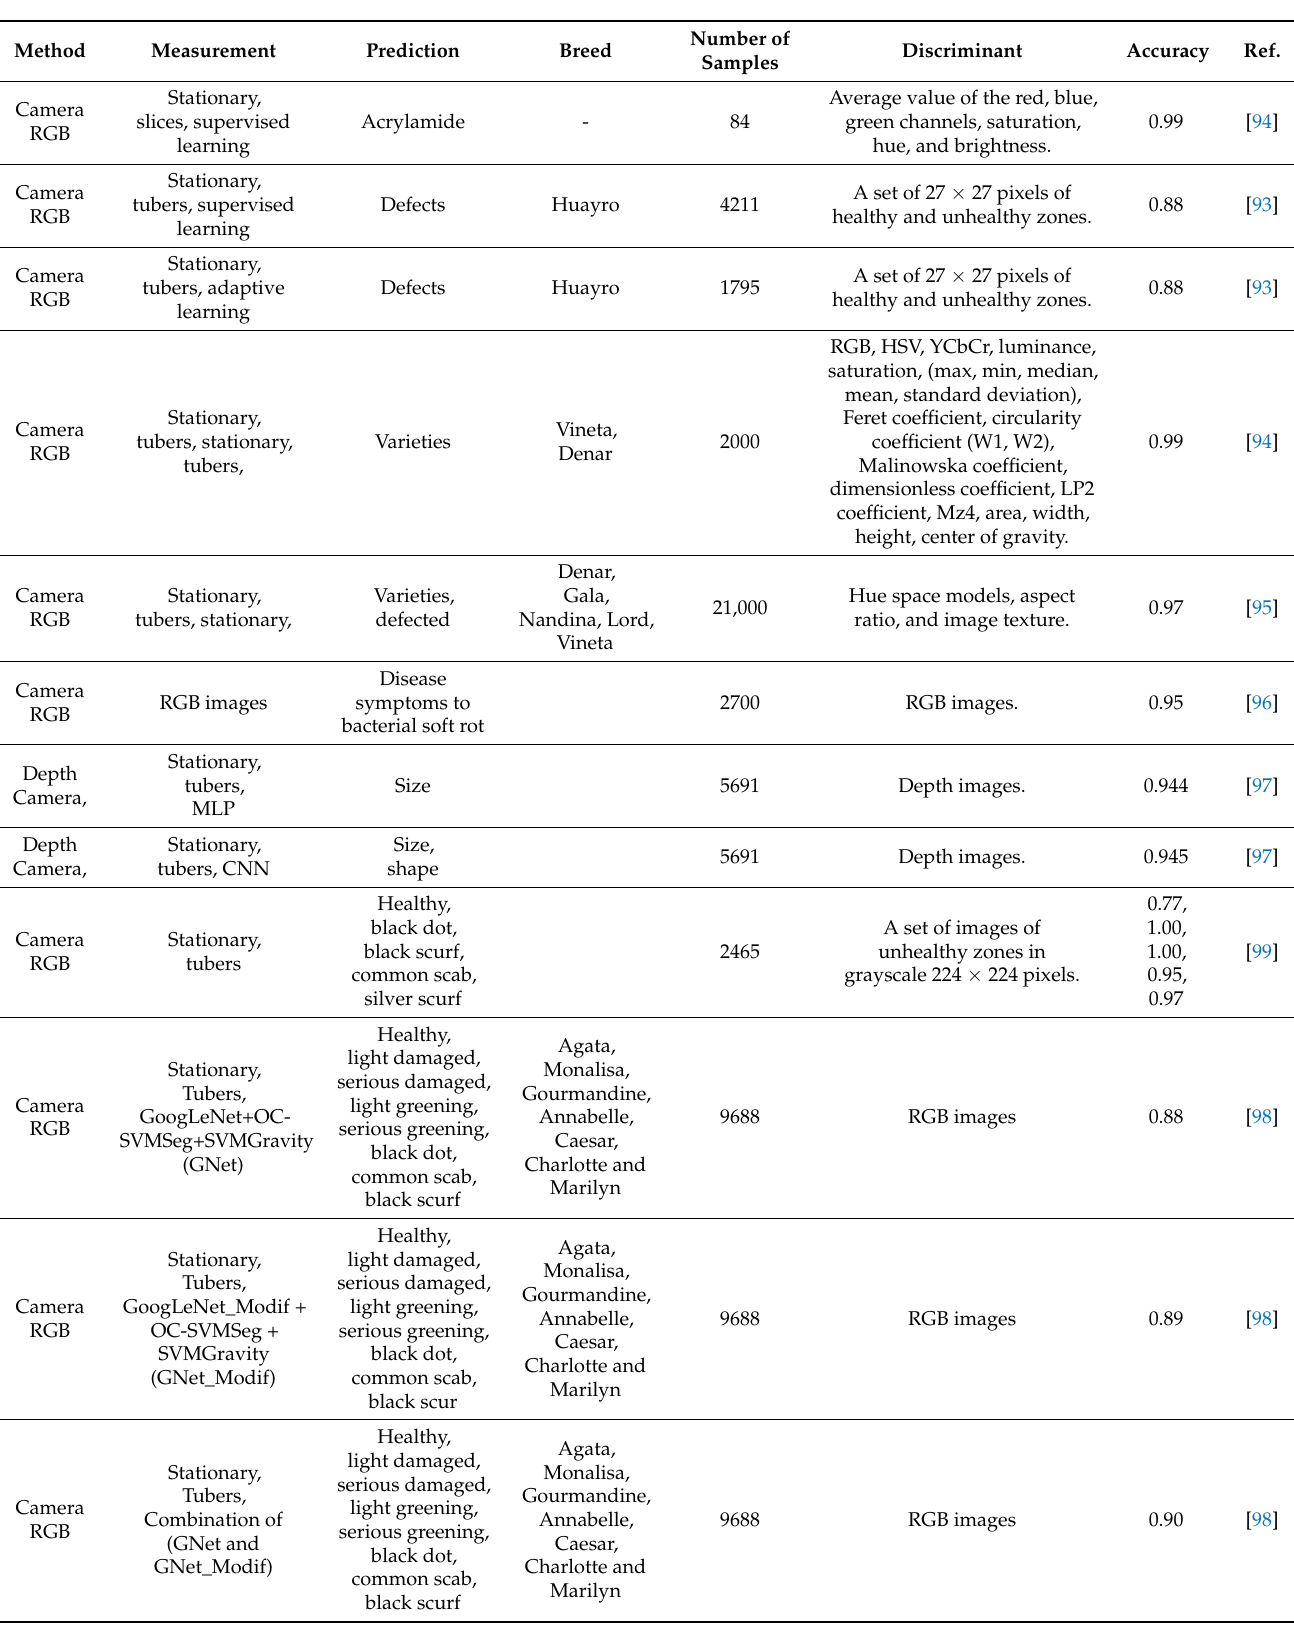
Table 3. Applications of artificial intelligence methods in quality assessment of